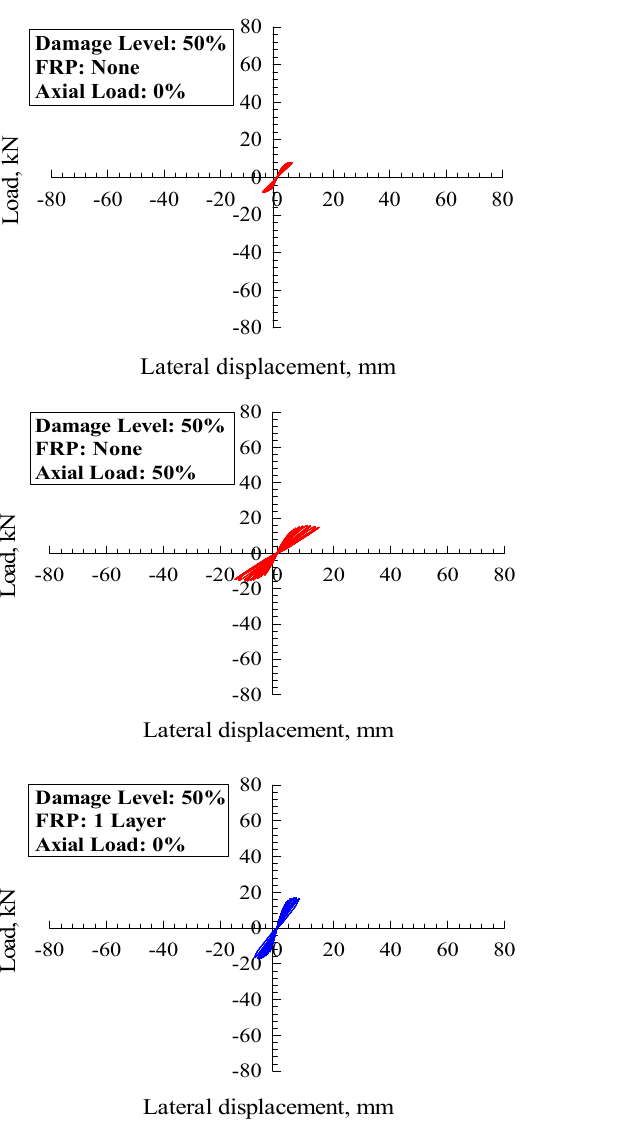
Figure 9. Hysteretic loops for 25% damaged joints.